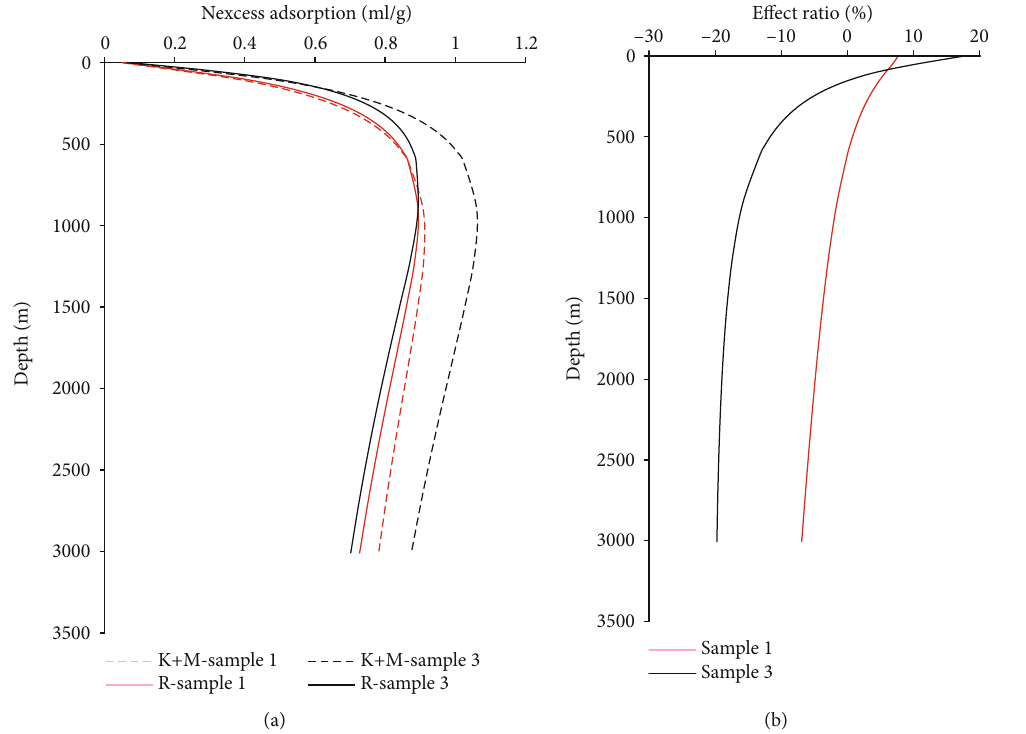
Figure 13: The comparison between calculated total organic-inorganic adsorption with the actual fi tting adsorption of original